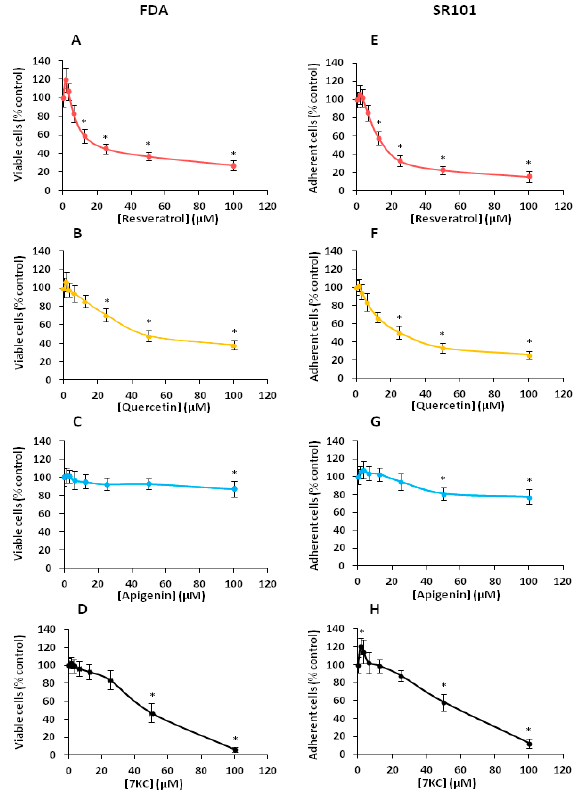
Figure 1. E ff ects of resveratrol, quercetin, apigenin and 7-ketocholesterol on cell viability and cell growth determined with the fluorescein diacetate and sulforhodamine 101 assays. Murine neuro-2a (N2a) neuroblastoma cells were cultured for 48 h with or without resveratrol (RSV), quercetin (QCT), apigenin (API) or 7-ketocholesterol (7KC; 1.5625 to 100 µ M). The results are in percentages relative to the control (untreated cells). Data obtained with the fluorescein diacetate (FDA) assay ( A – D ), and the sulforhodamine (SR101) assay ( E – H ) are shown. Data shown are expressed as mean ± standard deviation (SD) of four independent experiments performed in triplicate. Significance of the di ff erences between control (untreated cells) and RSV-, QCT-, API- and 7KC-treated cells; Mann–Whitney test: * p < 0.05 or less.